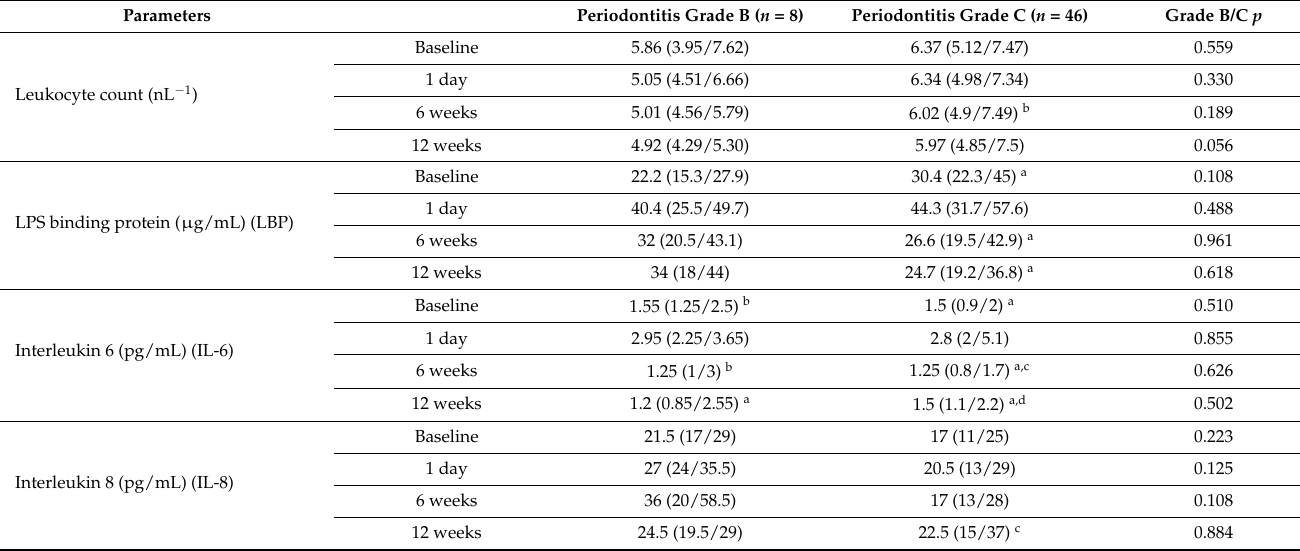
Table 6. Leukocyte counts LPS binding protein, interleukin 6 and 8 (median (lower/upper